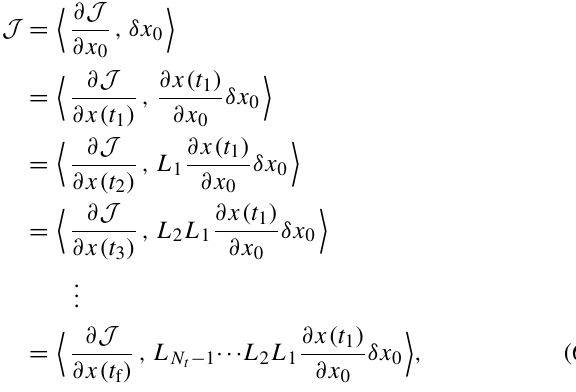
Figure 1. Schematic of AD applied to a simple function, F (a,b,c) = y = sin (a · b)c (see top). Intermediate results of the function evaluation are stored in the intermediate variables t1 and t2 . We wish to determine the gradient of F with respect to all inputs a,b , and c , symbolically expressed as ∇ F = [ a d , b d , c d ] . In SICOPOLIS-AD, the entire forward code is composed of many lines of simple functions, like F , in sequence (blue downward- pointing array on the left). OpenAD provides ∇ F by relating the partials of t1 and t2 to intrinsically differentiable functions, like sin() , here the red text, p1 (black upward-pointing array on the right). The partial derivatives of F are computed via the writing to memory of intermediate partial quantities, like dy (the adjoint or dual of y ) , dt1 , and dt2 . Thus, the sought sensitivity of a QoI, F , is related to input parameters a , b , and c in this algorithmic (albeit much simplified)